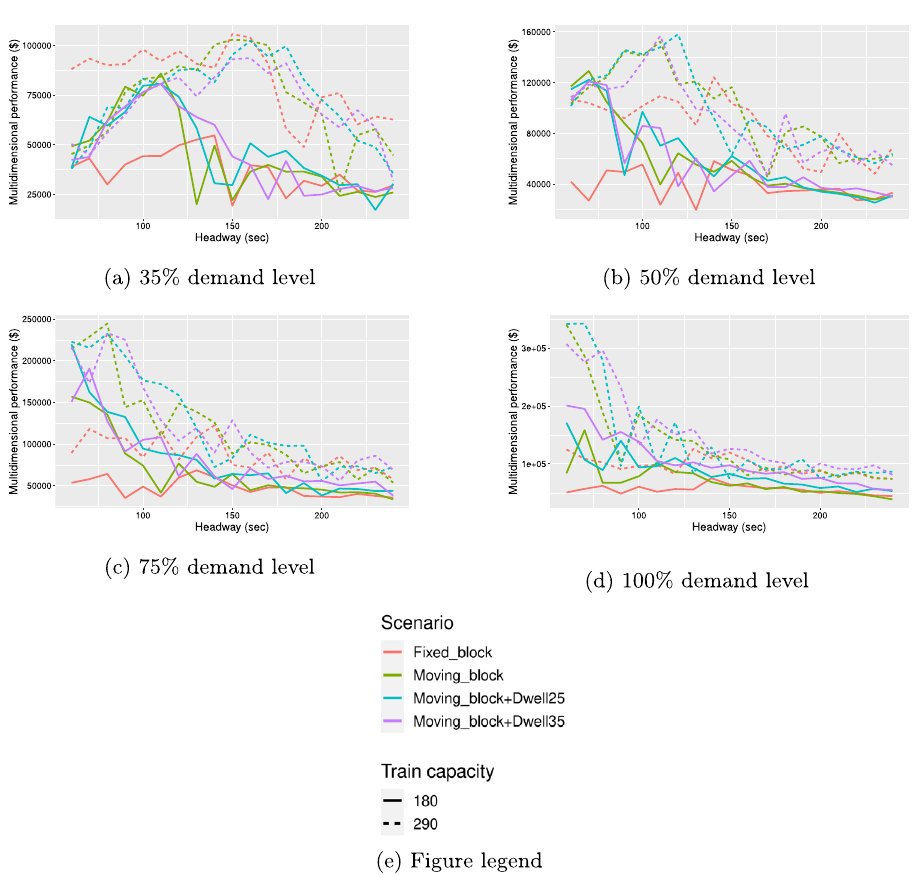
Figure 2. Performance vs headway for all operational scenarios, baseline Covid-19 crowding multiplier of